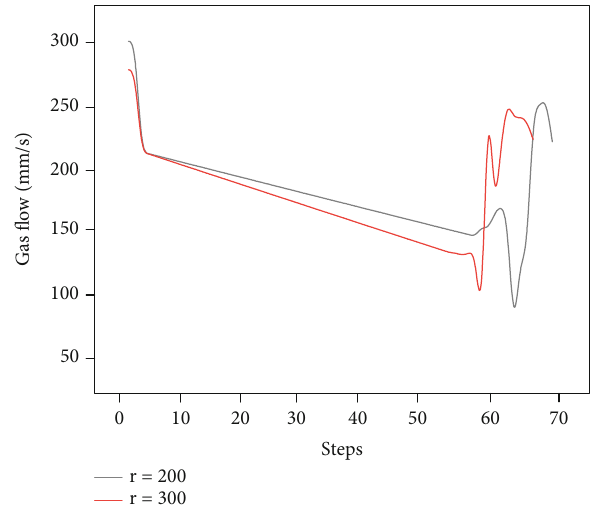
Figure 12: Flow changes of 200- and 300-mm holes.